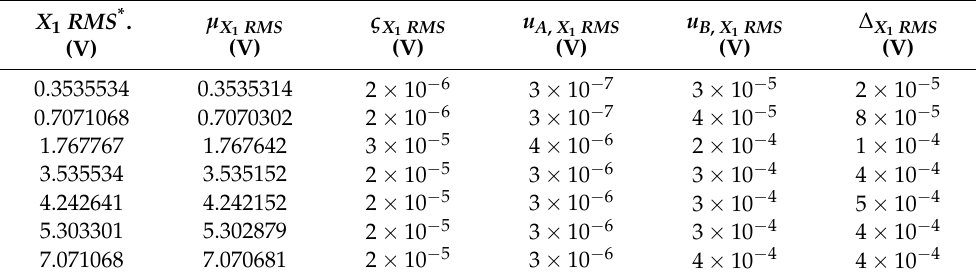
Table 5. Steady-state signal magnitude characterization